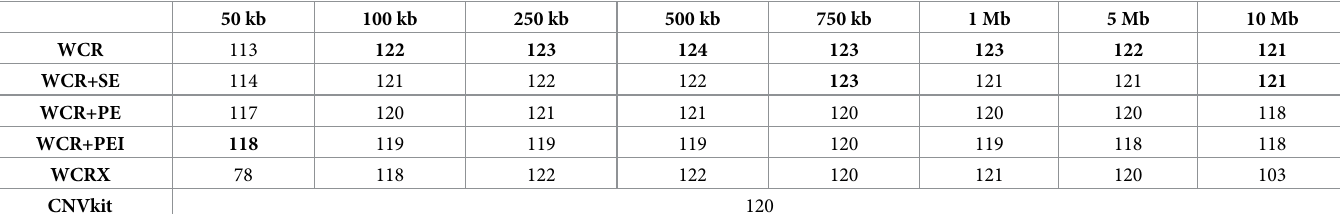
Table 1. Detection performance of T21 in experimental data. The number of � 10 Mb events with Z-scores � 5 on chromosome 21 detected by the methods in all T21 positive samples for varying bin sizes. Note that CNVkit does not depend on bin-sizes so only one performance measure is reported. 50